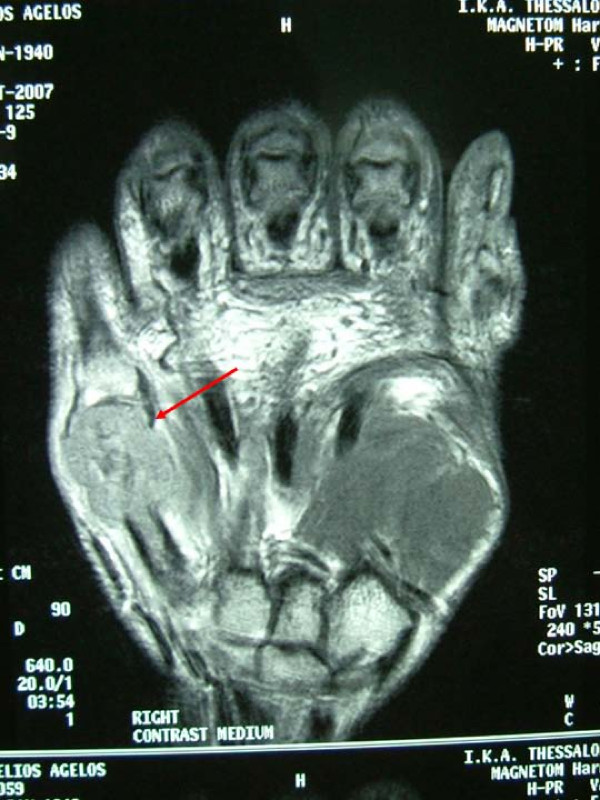
A solid mass at the area of 5th metacarpal.